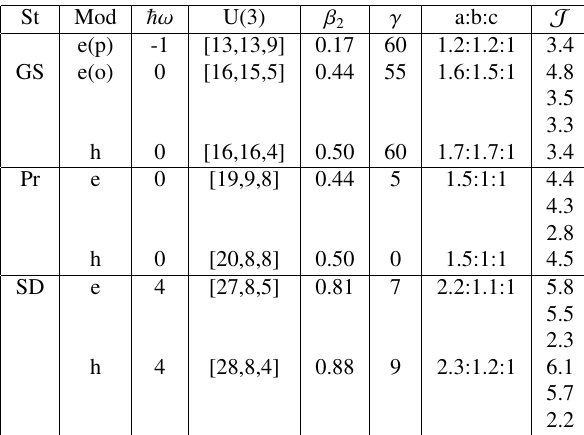
Table 1. Shape isomers in the 28 Si nucleus from the Nilsson model + quasi-dynamical SU (3) calculation. ‘e’ stands for e ff ec- tive U (3) quantum numbers, ‘h’ indicates the states correspond- ing to simple harmonic oscillator configurations. (p) and (o) mean prolate and oblate, respectively. The triaxiality, (cid:13) , is given in de- grees. The penultimate column indicates the axis ratio, while the final column presents the moment of inertia (in units of ~ 2 /